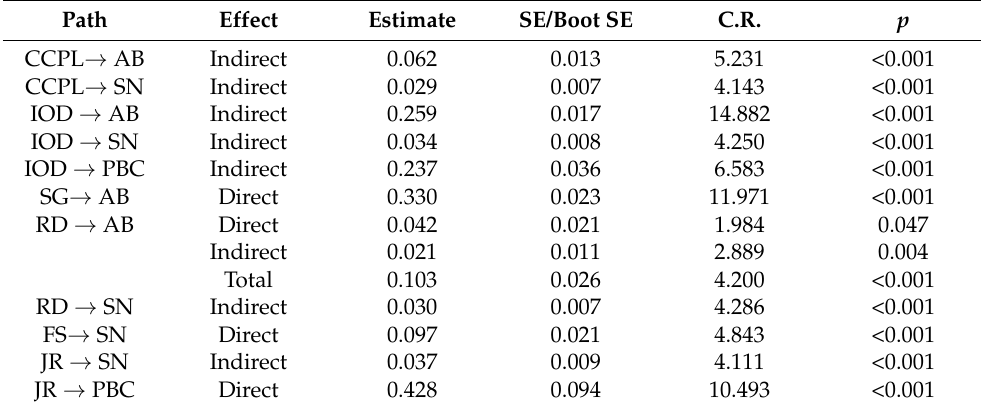
Table 4. The effects of factors on the three core variables of